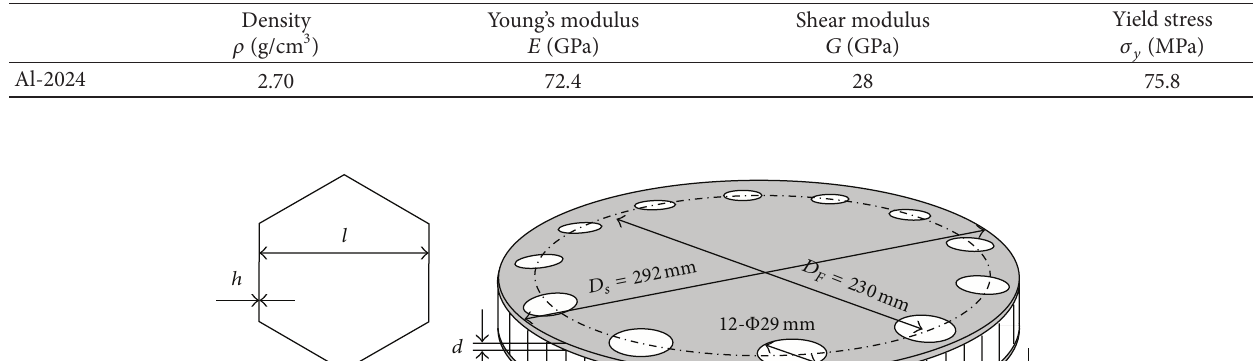
Table 1: Al-2024-mechanical properties.